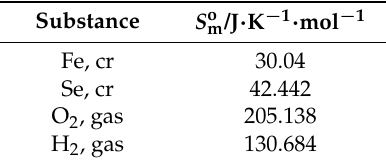
Table 4. Standard entropies of elemental substances at T = 298 K and p = 0.1 MPa [22].